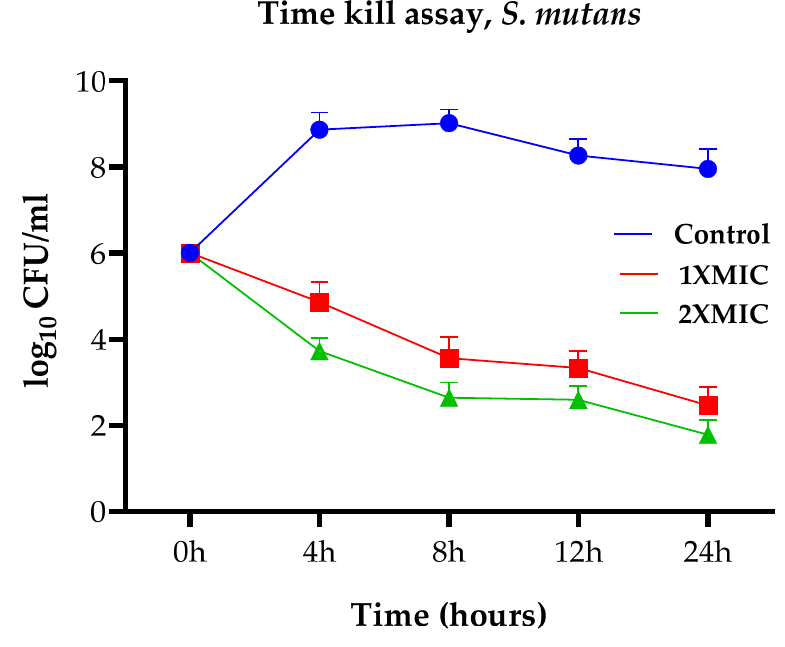
Figure 2. Time-kill assays of S. mutans .